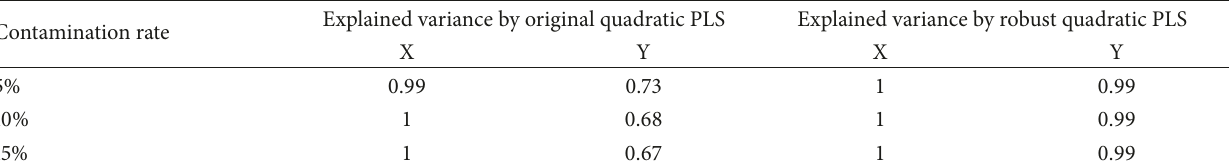
Table 2: Comparison between explained variance of proposed quadratic algorithm and original one in simulated dataset for the three contamination rates (5%, 10%, and 15%).